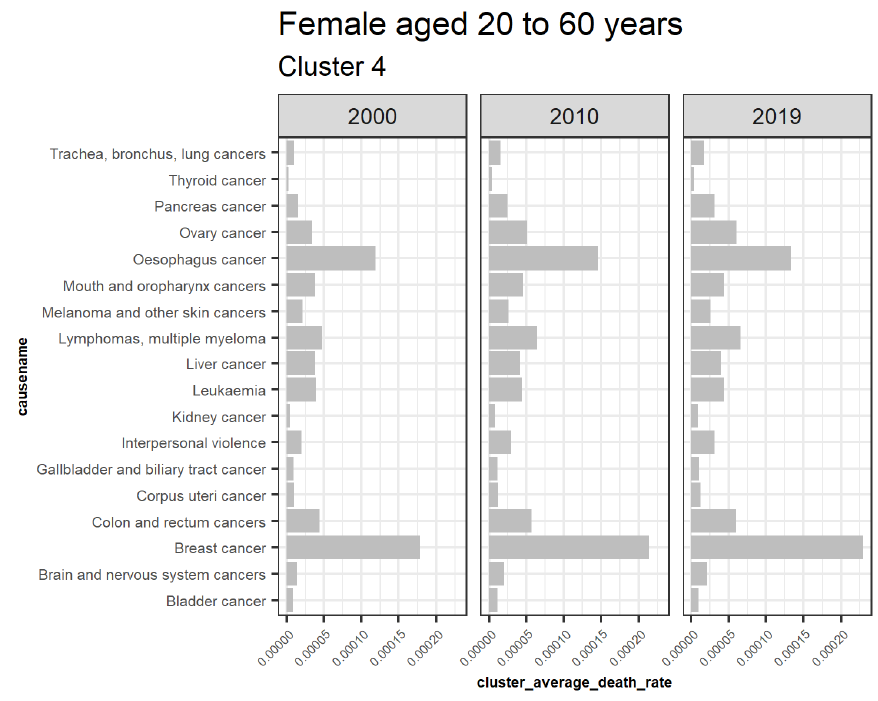
Figure 10. Increasing trend of the causes of death among younger females in cluster 4 for 2000, 2010, and 2019